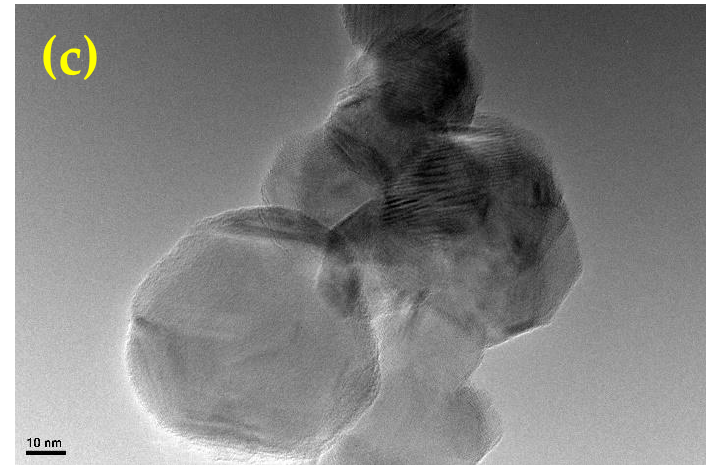
Figure 2. ( a ) FESEM image of the Al powder, ( b ) SiC, and ( c ) HRTEM images of SiC.